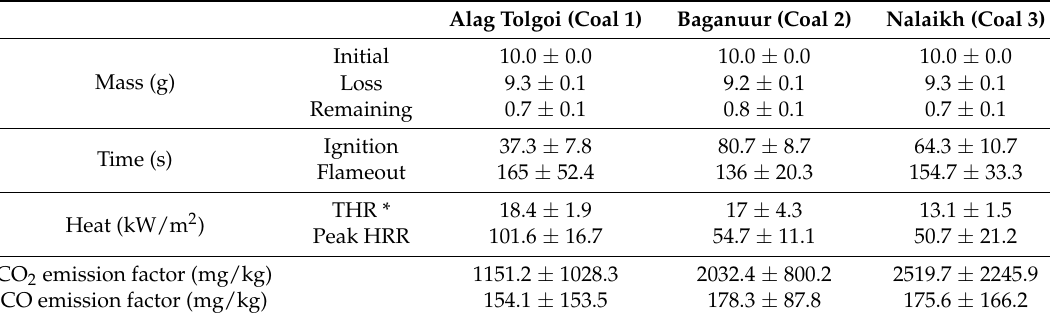
Table 2. Experimental results for the combustion of different